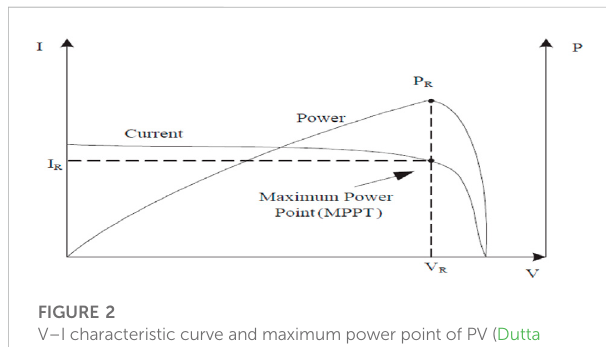
FIGURE 2 V – I characteristic curve and maximum power point of PV (Dutta et al.,